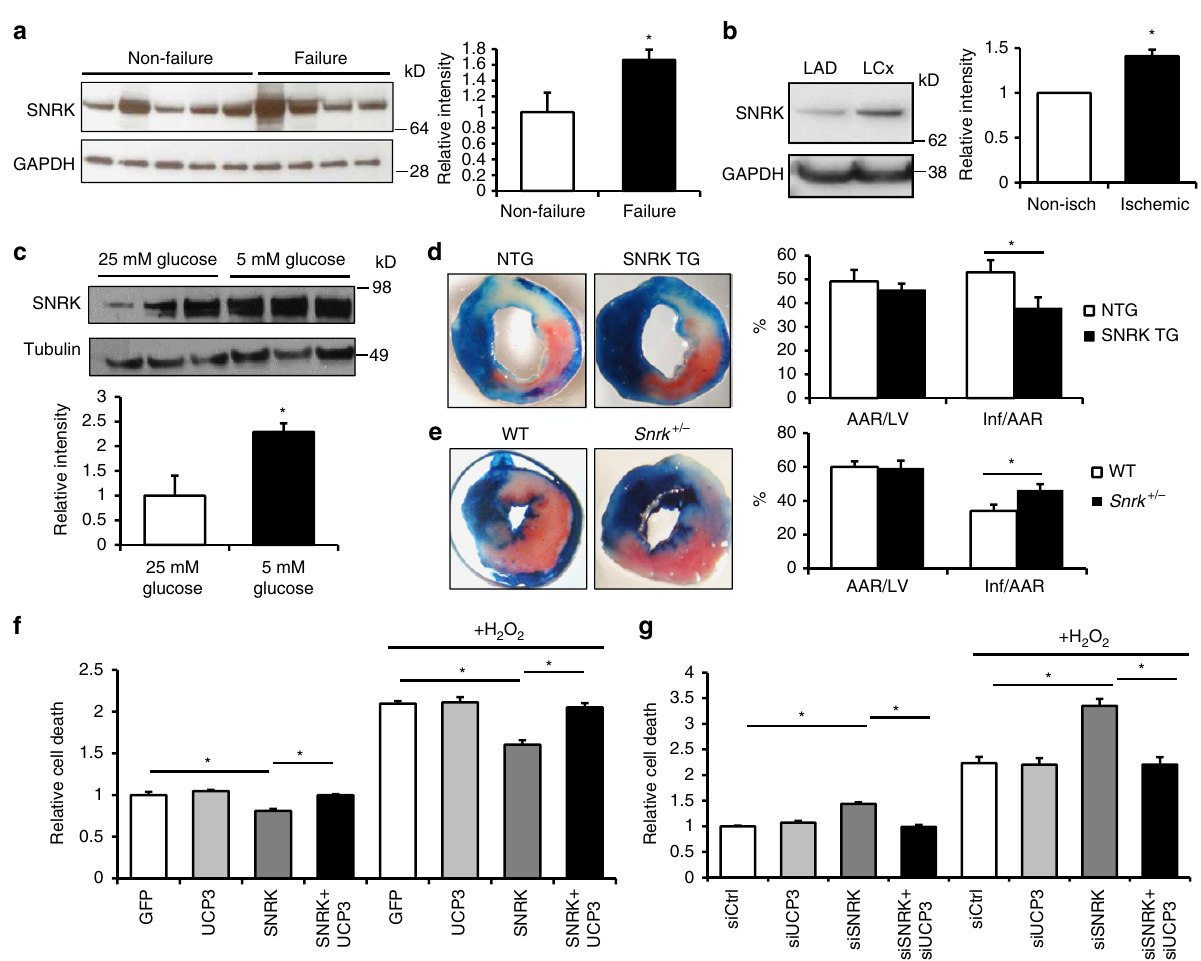
Figure 5 | SNRK decreases tissue damage in response to ischemia/reperfusion. ( a ) SNRK protein levels in human hearts from patients with no apparent cardiac disease (non-failure hearts) and from patients with cardiomyopathy (failure hearts). ( b ) SNRK protein levels in dog hearts in the non-ischemic left anterior descending artery (LAD) and in the ischemic left circumflex artery (LCx). Densitometry shows summary of three independent samples. ( c ) SNRK protein levels in HL1 cells grown for 36h in 5 or 25mM glucose-containing media. ( d ) Representative images of hearts from NTG and SNRK TG mice subjected to I/R. Graph shows summary of six mice for each group. ( e ) Representative images of hearts from WT and Snrk þ / (cid:2) mice subjected to I/R. Graphs show summary of four WTmice and seven Snrk þ / (cid:2) mice. ( f ) Cell death in HL1 cells with overexpression of GFP, SNRK and/or UCP3 after hypoxia, without and with H 2 O 2 treatment. ( g ) Cell death in HL1 cells with control, SNRK, and/or UCP3 siRNA treatment after hypoxia treatment, without and with H 2 O 2 treatment. Data are represented as mean ± s.e.m. * P r 0.05 by Student’s t -test or one-way ANOVA. ANOVA, analysis of